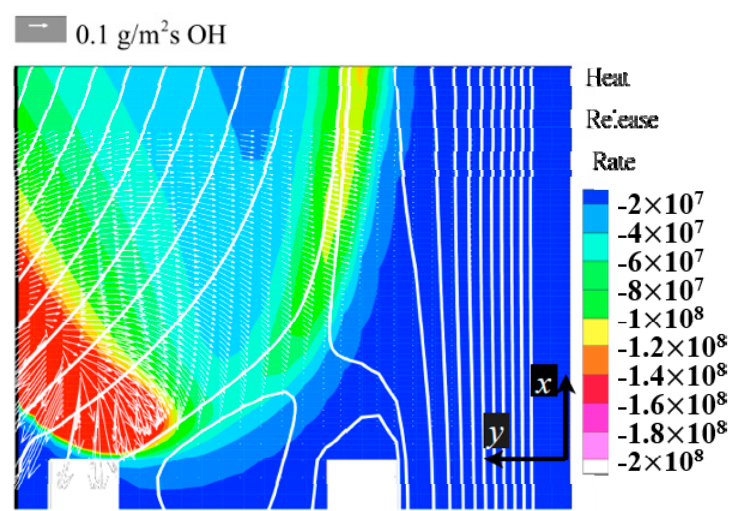
Figure 9. The OH diffusion vector (arrow) distribution in the post-flame region between the outer and the center flame, in contrast to the streamline (line) pattern and color-coded heat release rate. The burning conditions were for the center flame at φ = 0.5 and outer flame at φ = 0.88. The average jet exit speed was equal to 1 m/s for both center and outer flames.